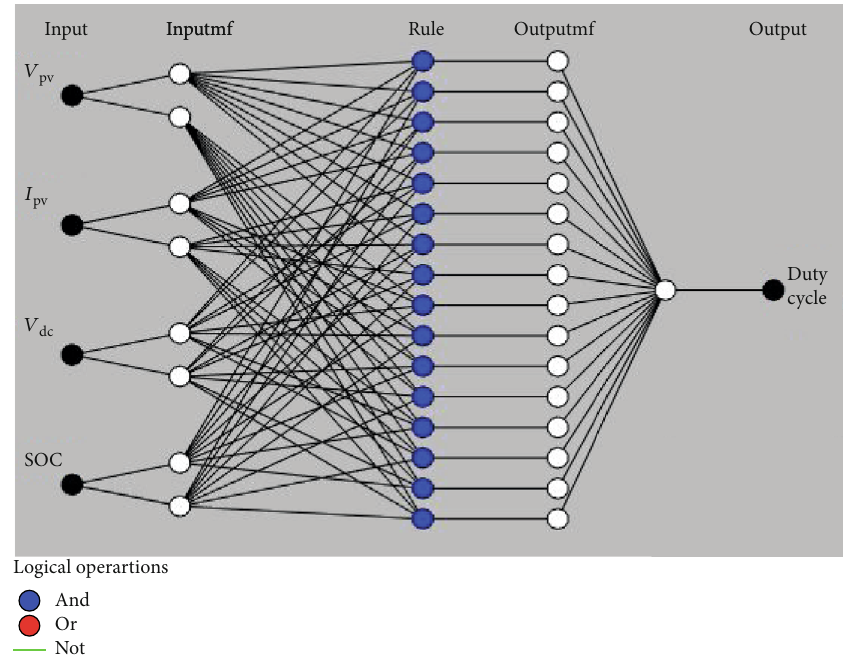
Figure 4: Structure of ANFIS for MPPT command and battery